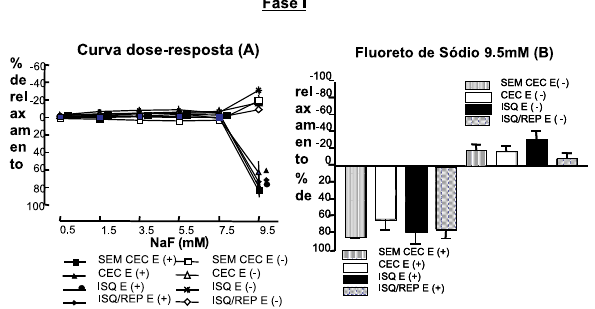
Fig. 4 - Fase I (Krebs com magnésio): A - Curvas dose- respostas ao fluoreto de sódio (NaF) em anéis de artérias coronárias caninas, contraídas com PGF a (2 x 10 -6 M), na 2 presença de indometacina (10 -5 M); B - Efeitos da dose 9,5 mM de fluoreto de sódio (NaF) em anéis de artérias coronárias caninas, contraídas com PGF2a (2 x 10 -6 M), na presença de indometacina (10 -5 M). (SEM CEC = grupo controle, CEC = grupo de animais